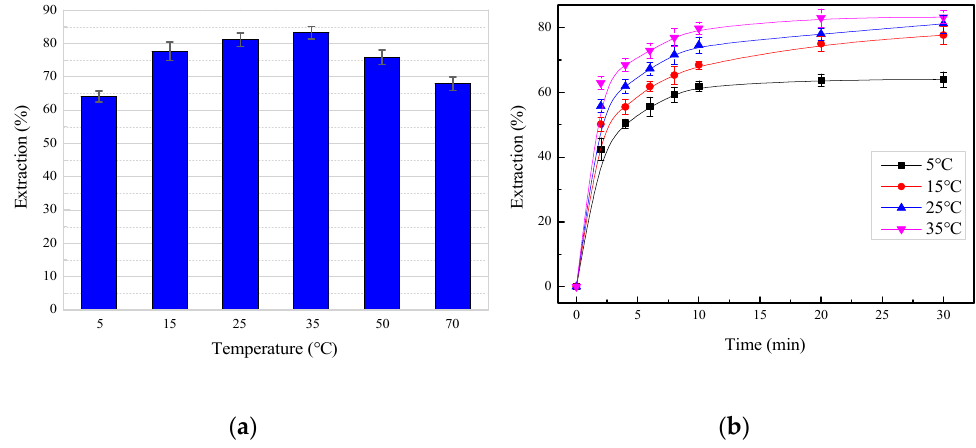
Figure 8. The effect of temperature on the zinc extraction: ( a ) 30 min of leaching time; ( b ) time difference. The forms of shrinking core models that account for diffusion through the